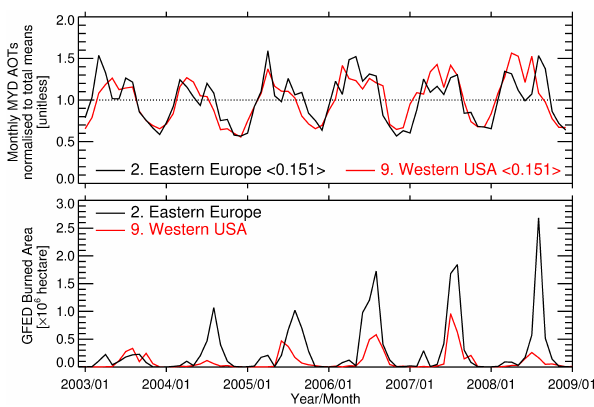
Figure 12. Plots of the time series of atmospheric AOTs normal- ized to their average mean values from MODIS-Aqua (MYD) data set (top) and Global Fire Emissions Database (GFED) burned area (bottom) over eastern Europe (region 2, black) and the western USA (region 9, red) from 2003 to 2008.